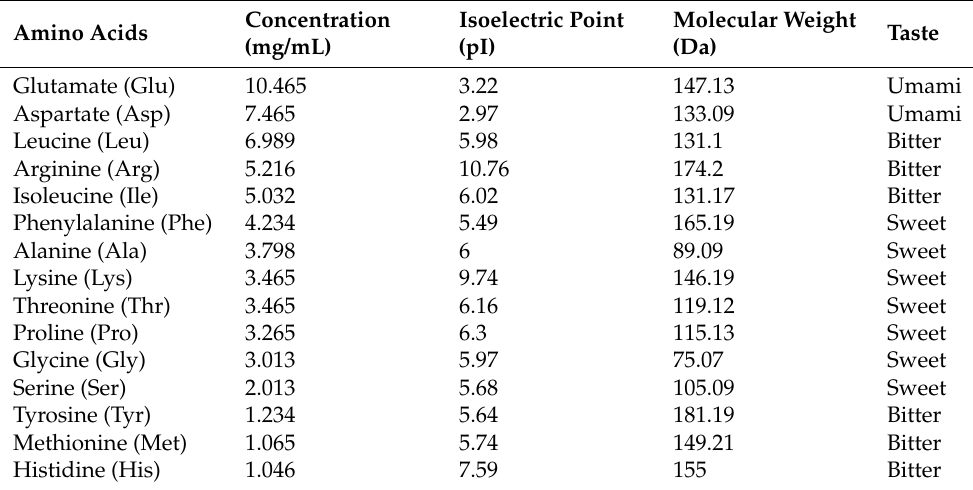
Table 2. Composition, concentration, and properties of amino acids in the soy